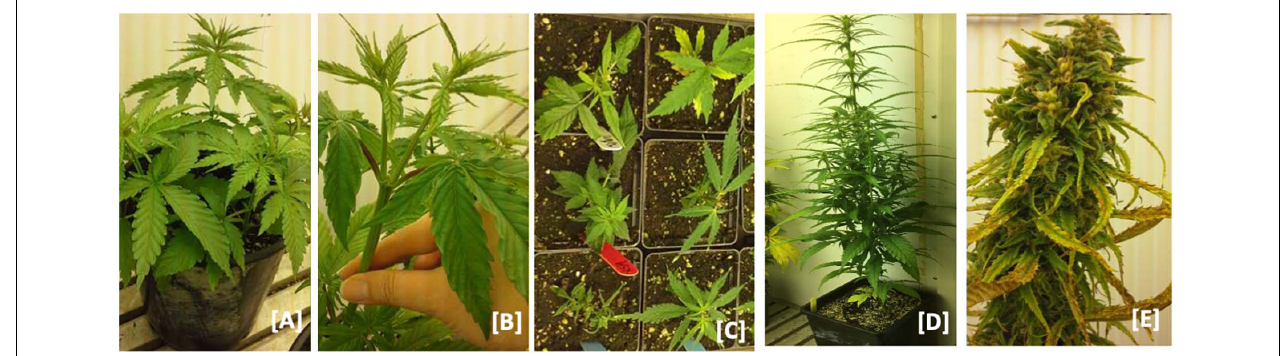
FIGURE 2 | Hemp nodal cloning. (A) Hemp plants at 6–8 leaf stage. (B) Elongated lateral branches after terminal buds removed from female plants (C) lateral branches planted in soil after excision from mother plants and. (D) Vegetative clones transferred to 7-inch pots after roots were established and grown. (E) Vegetative clone at